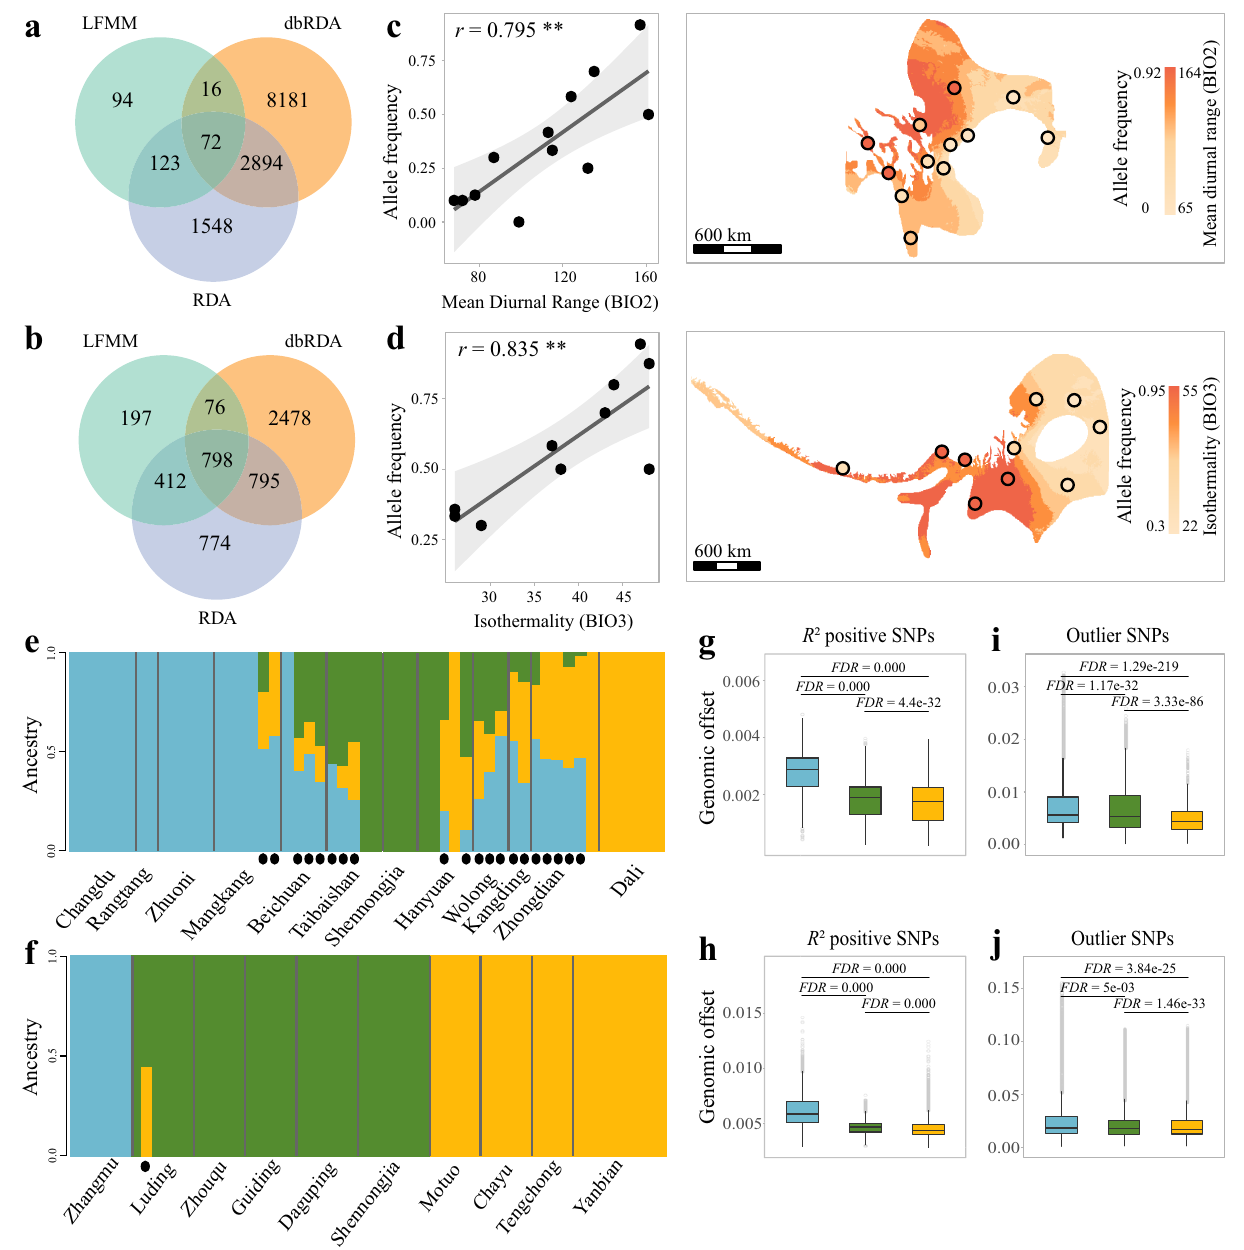
Fig. 4 | Intraspeci fi c variation in genotype-climate association. a , b Venn dia- gram depicting overlaps between outlier single-nucleotide polymorphisms (SNPs) detected using LFMM, RAD and dbRAD in T. elliotii ( a ) and P. monticolus ( b ), respectively. c , d Relationships (left) and genotype-climate associations (right)betweentheallelefrequencyofSNPin CRB1 andthemeandiurnalrangein T. elliotii (c, n =55 individuals) and the isothermality in P. monticolus ( d , n =58 individuals). Light grey shade indicates the 95% con fi dence interval of the regression. e , f Population genetic structure plots of outlier SNPs separating groups of individuals tolerant to cold-dry (blue), warm-dry (green) and warm- humid conditions (yellow) in T. elliotii ( e ) and P. monticolus ( f ). The black dots show individuals with mixed genetic components. g , j The cold-dry tolerant groups ( T. elliotii , n =21,402 grids; P. monticolus , n =6926 grids) show greater genomic offsets than the warm-humid ( T. elliotii , n =7061 grids; P. monticolus ,